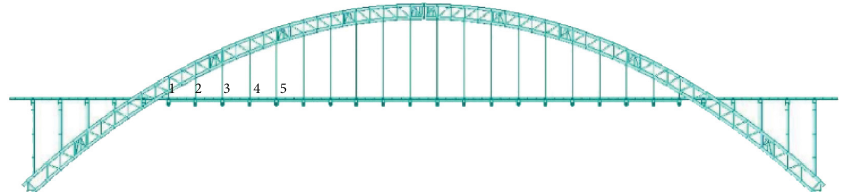
Figure 12: Side-view of the layout of alignment measurement points of the bridge deck.